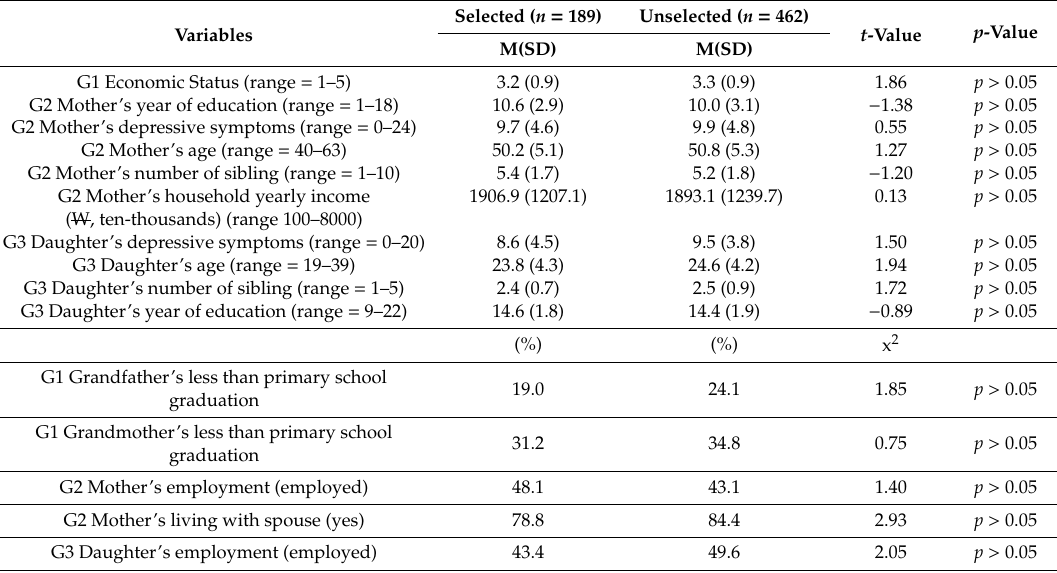
Table 1. Descriptive statistics for selected and unselected samples.